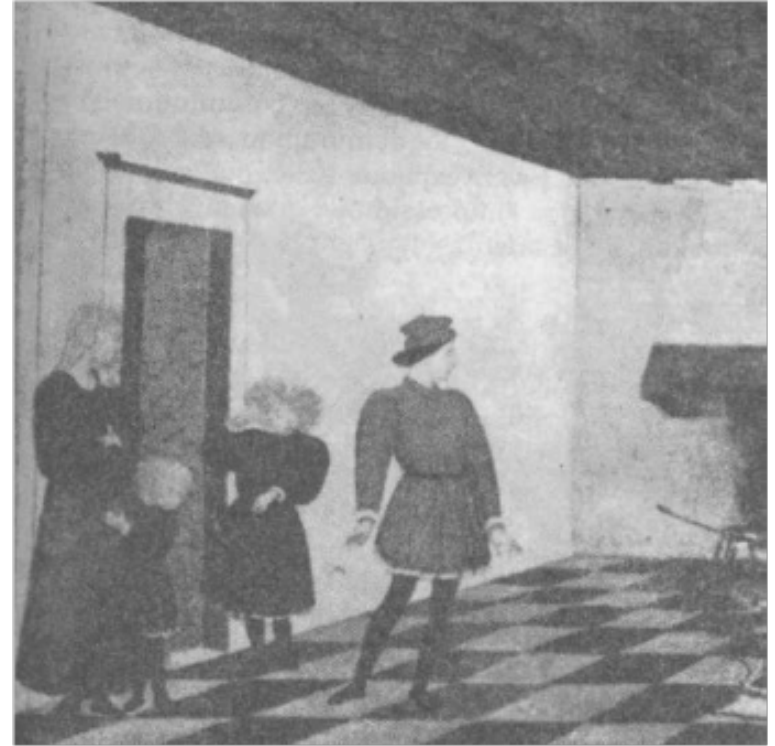
Figure 8 . Anonymous. La Profanation de L’Hostie in Nadja